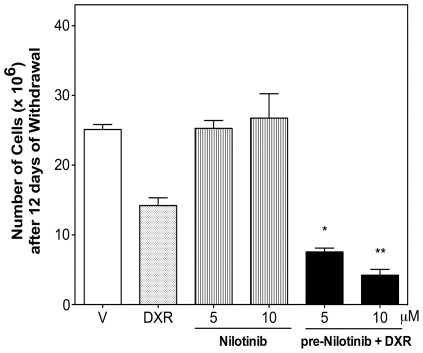
Nilotinib plus doxorubicin-treated leiomyosarcoma SK-UT-1 cells showed prolonged inhibition of cell growth after drug withdrawal.Cells were pre-treated with vehicle or nilotinib for 24 h, and DXR (0.05 µM) was then added to the corresponding wells and treatment continued for another 72 h. Cells were then recovered, diluted and reseeded at a density of 1.8×104 cell per well with culture medium without any further compounds. After 12 days, cells were counted using a hemocytometer. Values are mean ± SEM of three independent experiments. *
P<0.05 and **
P<0.01 versus DXR-treated cells.